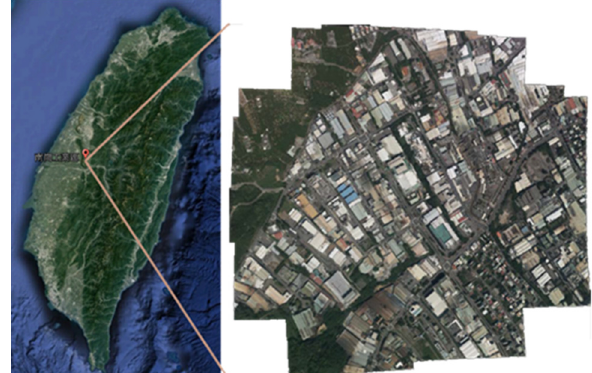
Figure 1. Location of the test area in Taiwan and its image